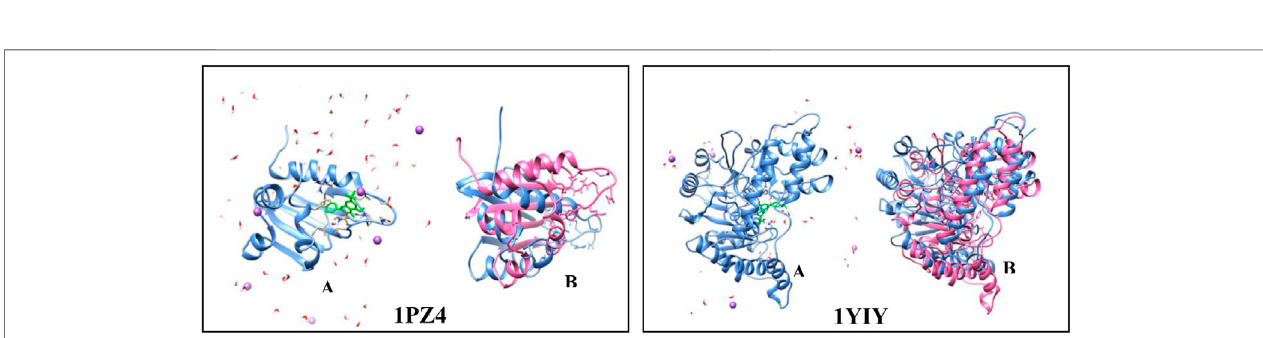
FIGURE5| Simulationofmoleculardynamics. (A) protein(blue)complexedtothesulfated fl avonoidbinder(green)inthepresenceofwater(redandwhite)andions (purple). (B) protein before the simulation (blue) and after the simulation in 100 ps (pink).